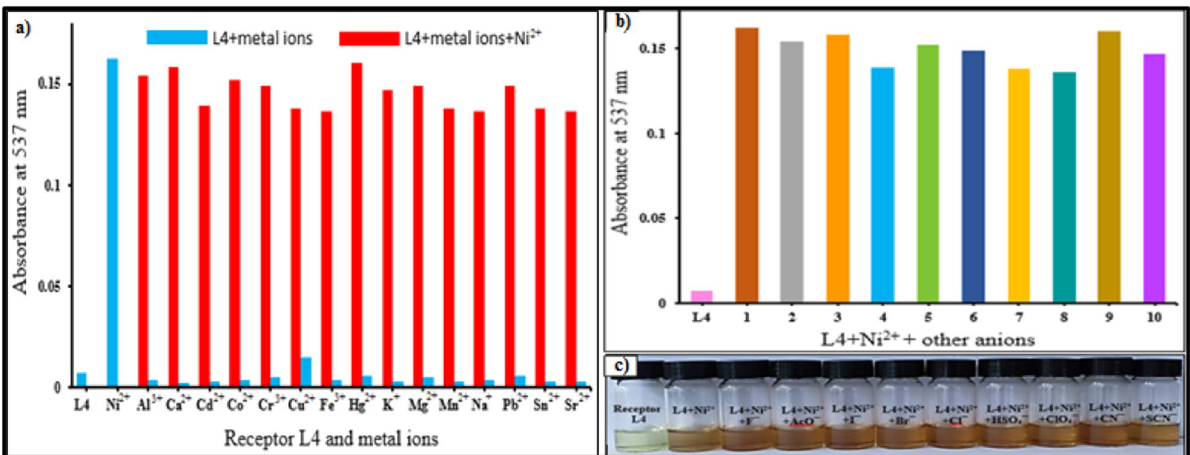
Figure 6. ( a ) Absorbance responses of L4 (20 µM) in the presence of Ni 2+ (10 µM) with 10 equivalents of various metal ions in DMSO – H 2 O (v/v = 1:2) HEPES buffer solutions at pH = 7.4, ( b ) Absorbance at 537 nm of receptor L4 (20 µM) in the presence of Ni 2+ (10 µM) in the presence of 10 equivalents of various anions in DMSO–H 2 O (v/v = 1:2) HEPES buffer solutions at pH = 7.4, ( c ) The color changes of L4 upon addition of Ni 2+ and various anions